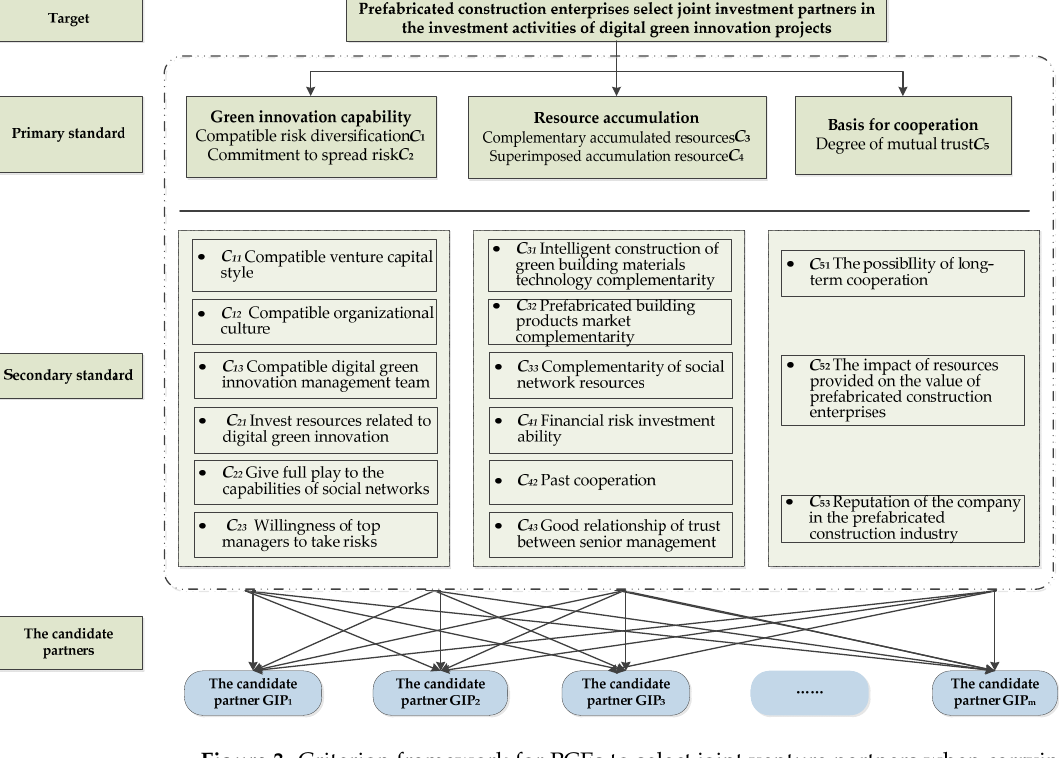
Figure 3. Criterion framework for PCEs to select joint venture partners when carrying out digital green innovation projects.